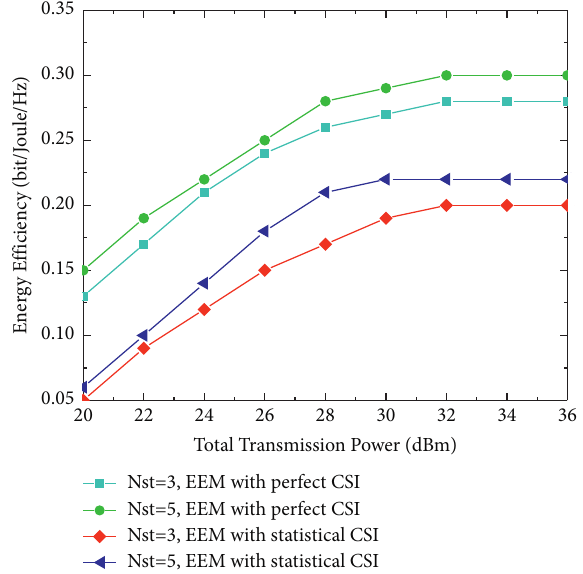
Figure 4: The maximal achievable EE versus the total transmission power by varying the number of the transmitting antennas at the ST.